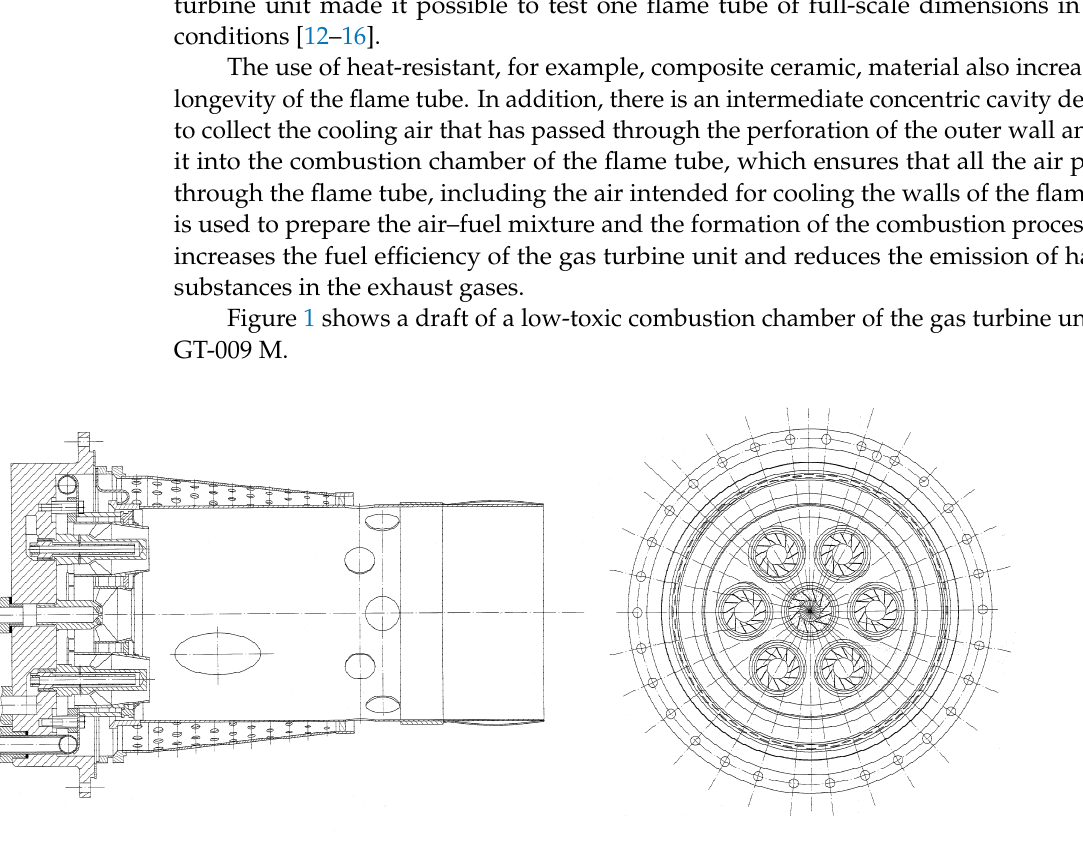
Figure 1. Draft of a low-toxic combustion chamber of the gas turbine unit type GT-009